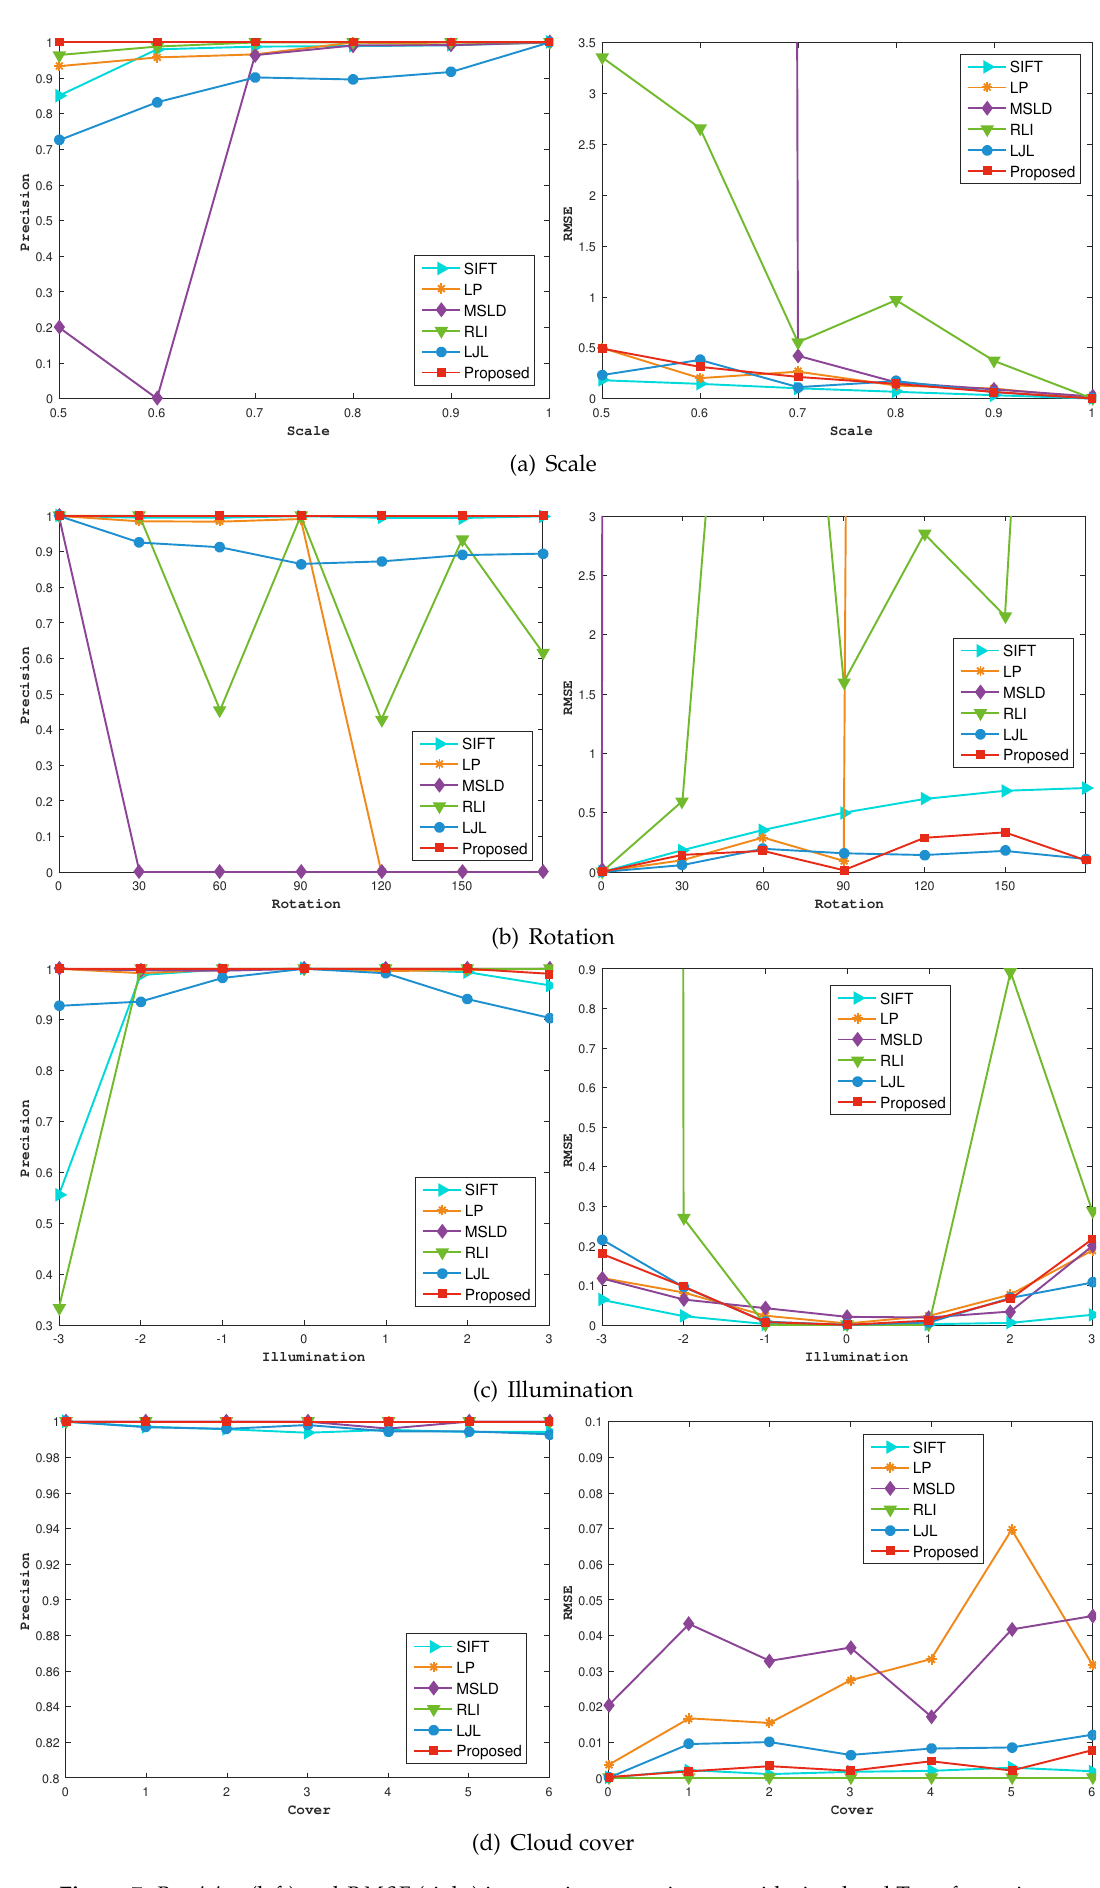
Figure 7. Precision (left) and RMSE (right) in experiments on images with simulated Transformations. ( a ) Scale; ( b ) Rotation; ( c ) Illumination; ( d ) Cloud cover.